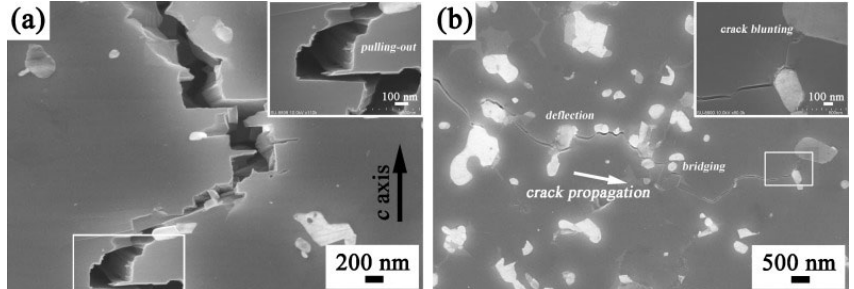
Fig. 37 Crack propagation on different polished surfaces of textured Ti 3 AlC 2 ceramic: (a) parallel to the c -axis orientation; (b) perpendicular to the c -axis orientation. The inset micrographs are the magnified region in the figures. Reproduced with permission from Ref. [266], © Elsevier Ltd. 2014.